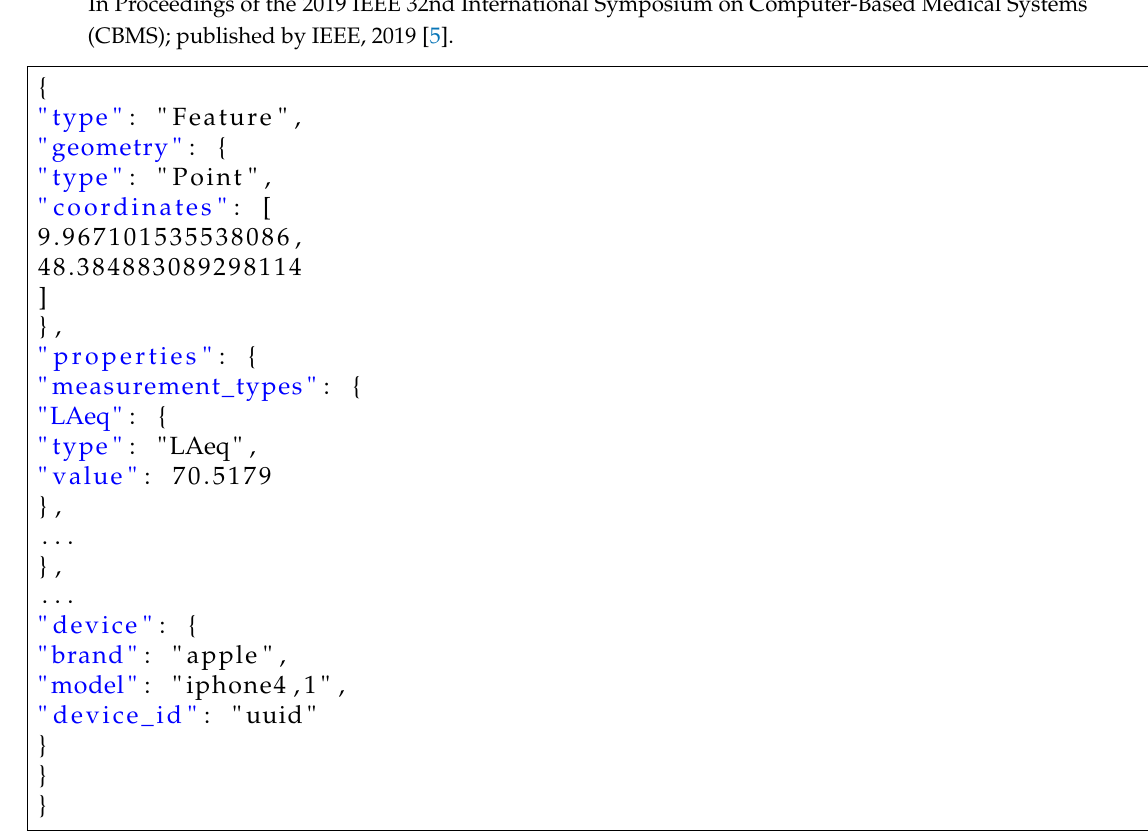
Figure 6. Data flow of noise measurements. Reproduced with permission from Kraft et al.,